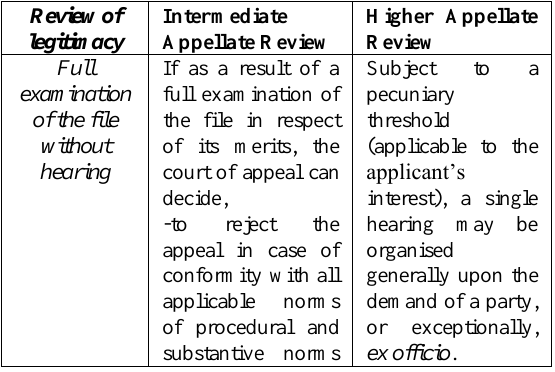
Table 7. The Subsequent Stage of